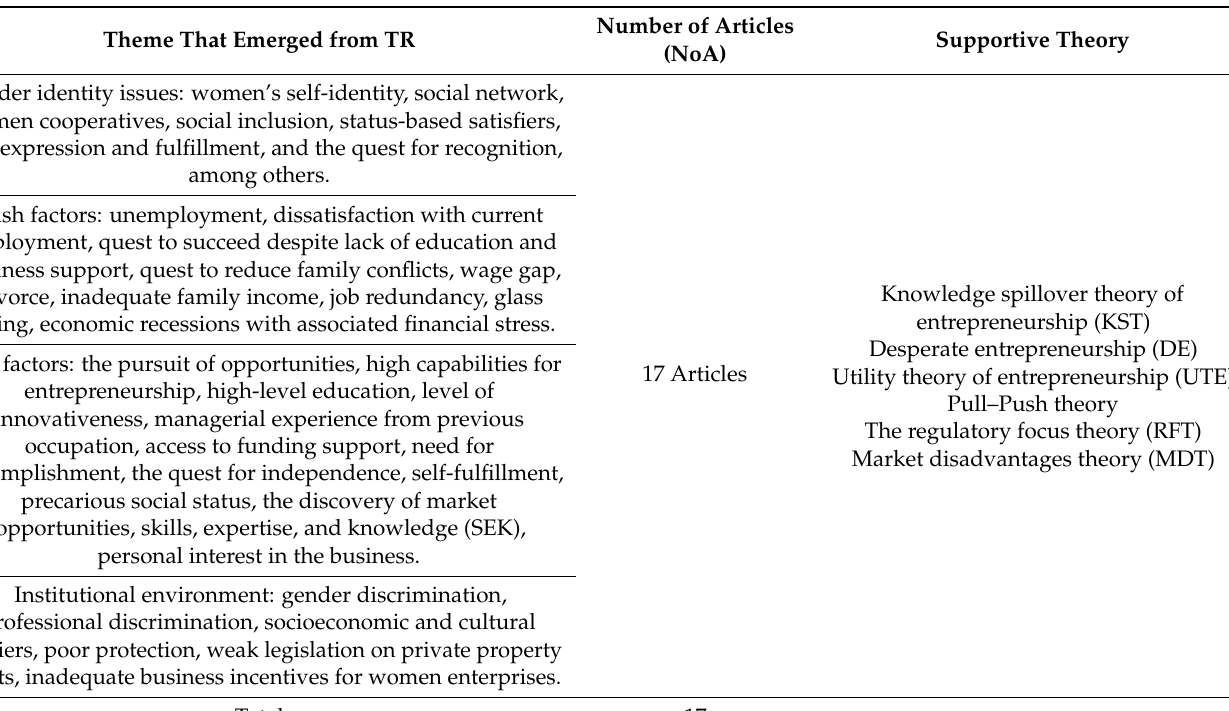
Table 3. Motivational factors for TE among women